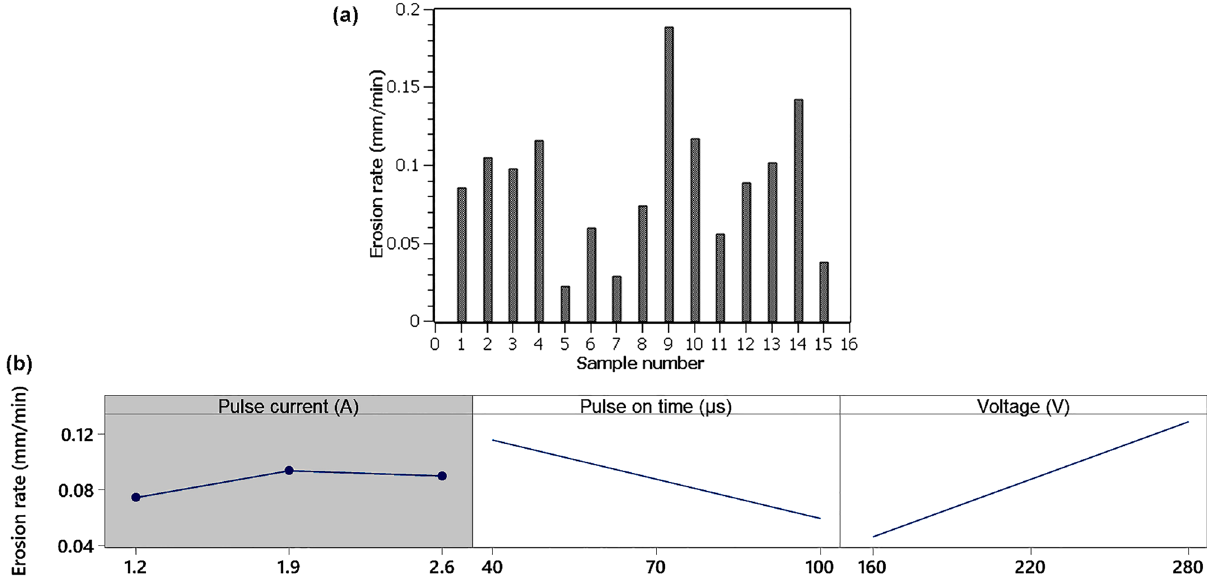
Figure 2. ( a ) Eroding rate of individual samples, ( b ) main effect plots for erosion rate (A gray background represents a term not in the model, which is not statistically significant and is therefore not included in the